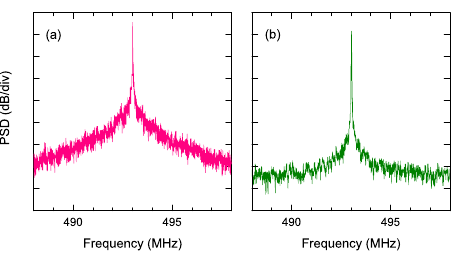
Figure 6: RF intermodal beat notes at 493 MHz, corresponding to the cavity FSR, for (a) the IR and (b) the green combs.